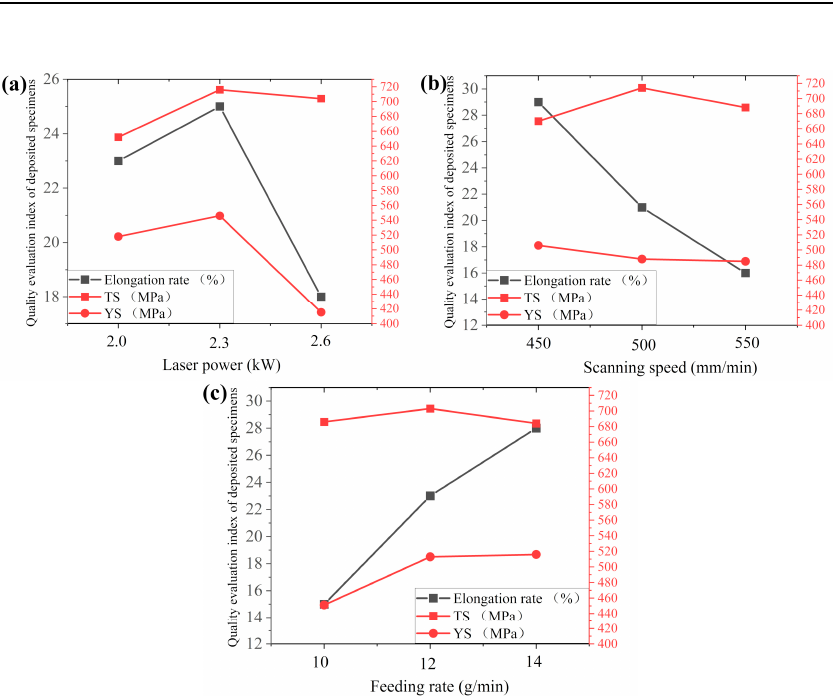
Figure 15 is a range analysis diagram showing the variation of the tensile strength (TS), yield strength (YS), and elongation with process parameters. As can be seen from Figure 15a, TS, YS, and elongation first increase and then decrease with the increase in laser power. As shown in Figure 15b, TS and YS have little effect on the scanning speed, but the elongation decreases with the increase in the scanning speed. It can be seen from Figure 15c that TS and YS increase at first and then decrease with the increase in the powder feeding rate, but the elongation increases with the increase in the powder feeding rate.